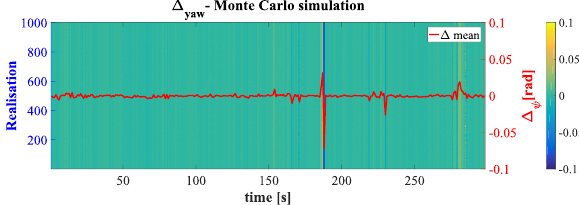
Figure 7. Variation of the heading ψ . Vehicle 1 - Sensor setup 1